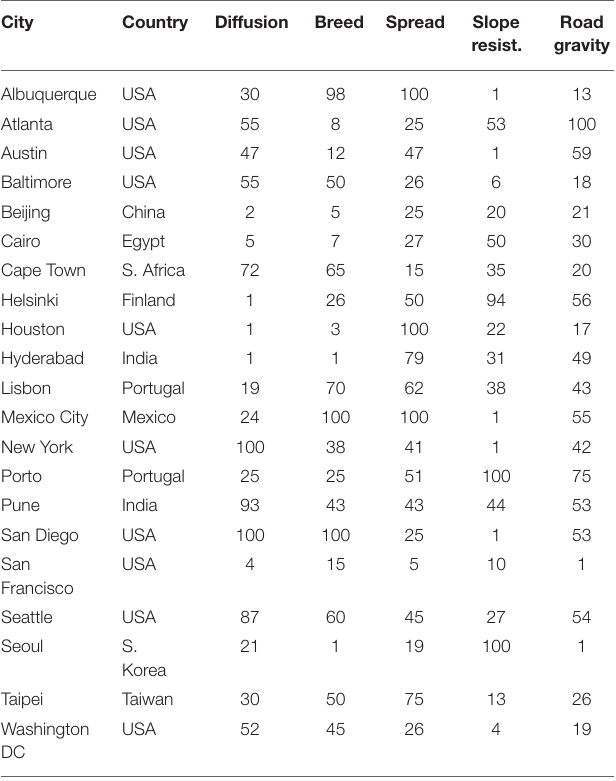
TABLE 2 | The analyzed cities and their SLEUTH coefficients. City Country Diffusion Breed Spread Slope